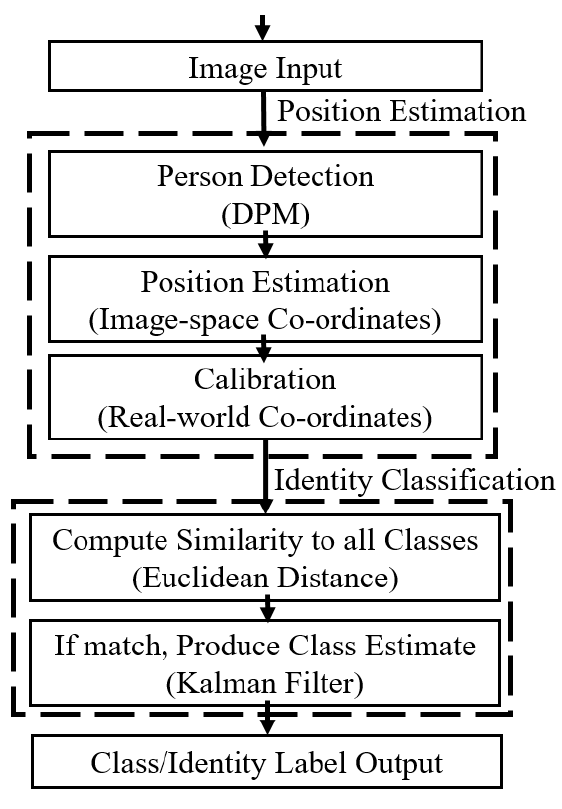
Figure 3. The position estimation and identity classification process in the spatio-temporal